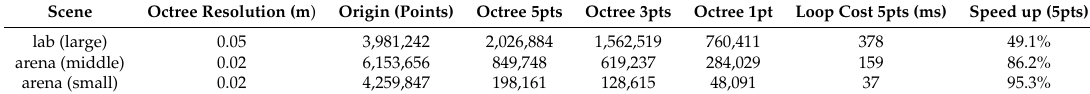
Table 2. Efficiency of the octree structure.